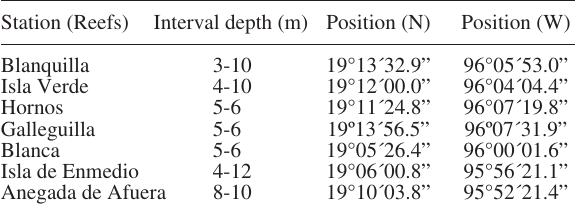
Table 1. – Geographic locations and depths of sampling stations from the Veracruz Coral Reef System National Park during June, August and October,